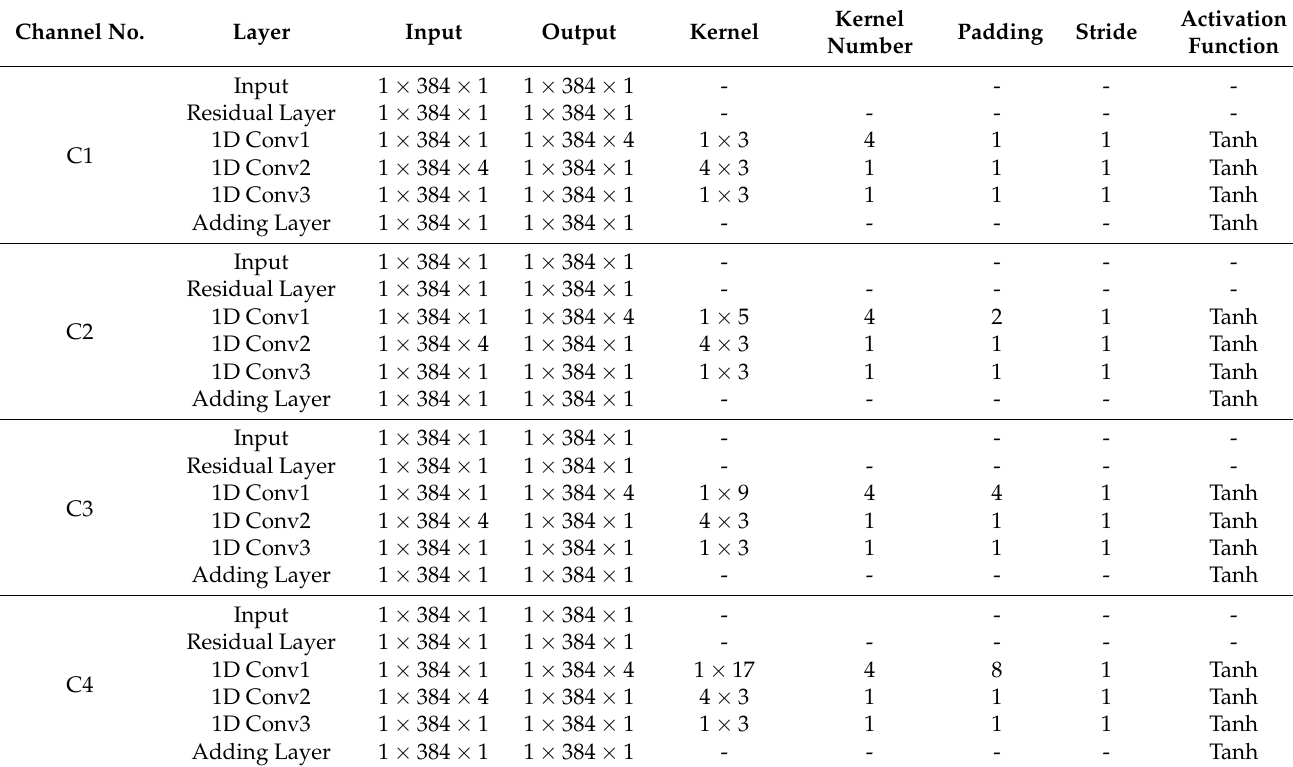
Table 6. Layer architecture of the multi-channel 1D convolutional neural network-temporal convolu- tion network.